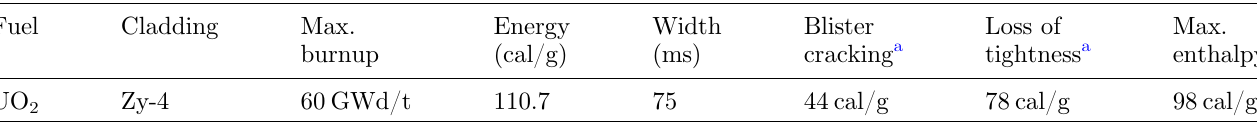
Table 1. Main characteristics of the CABRI REP-Na8